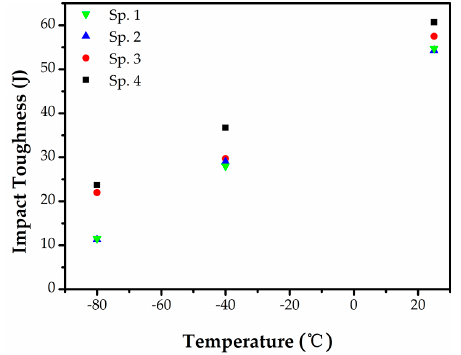
Figure 14. Charpy-V impact toughness of weld metals welded at different ambient pressure.